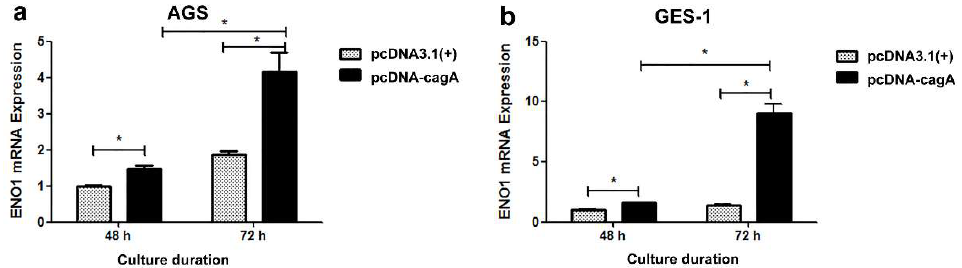
Figure 5. ENO1 mRNA expression in the gastric cells AGS (a) and GES-1 (b) post transfection with pcDNA- cagA and pcDNA3.1(+), respectively. *, p < 0.05. At 72 h post transfection, the cagA+ GES-1 cells produced a much higher ENO1 level than the cagA − GES-1 cells and the cagA + AGS cells.